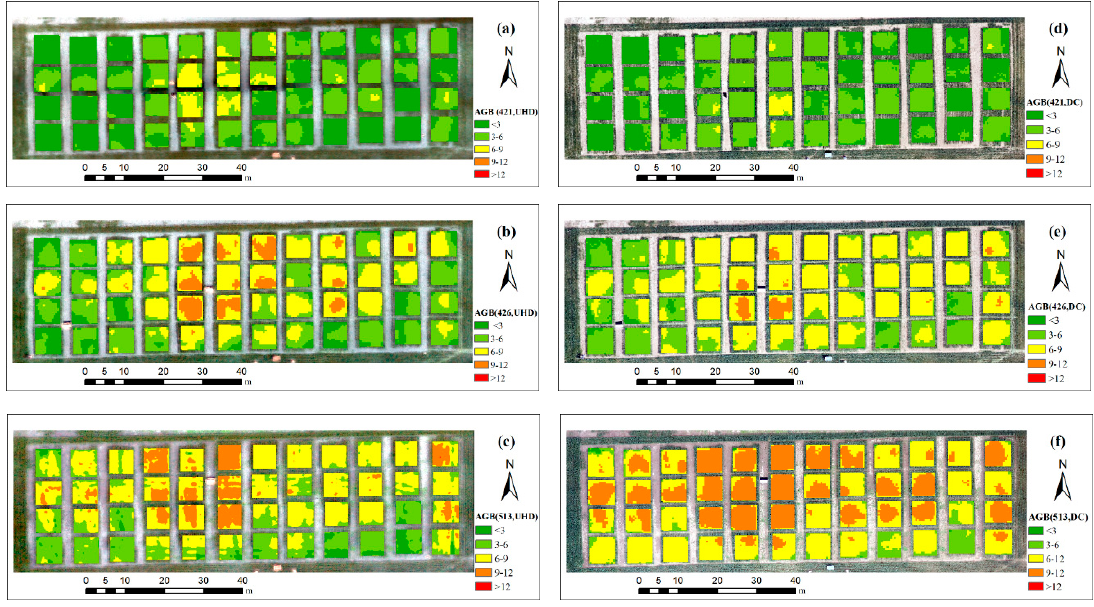
Figure 10. Above-ground Biomass (t/ha) maps made using UAV-UHD, UAV-DC, and PLSR. ( a ) UHD on 21 April; ( b ) UHD on 26 April; ( c ) UHD on 13 May; ( d ) DC on 21 April; ( e ) DC on 26 April; and ( f ) DC on 13 May. Note: UHD- indicates data measured using the snapshot hyperspectral sensor mounted on the UAV; and DC- indicates data measured by using the digital camera mounted on the UAV.